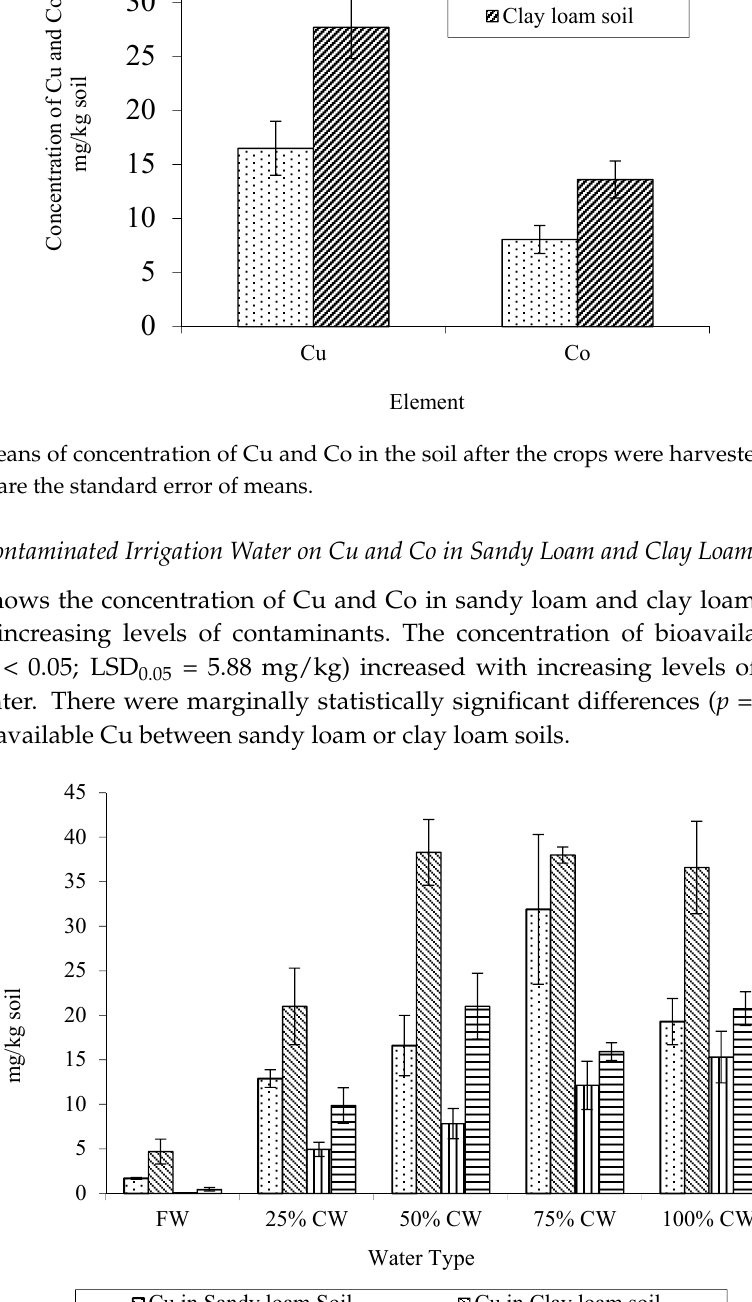
when irrigated with 100% CW. In clay loam, the concentration of Co increased from 0.5 mg/kg soil